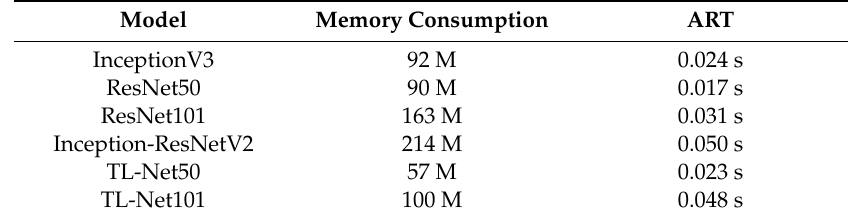
Table 4. The memory consumption and the running time of some typical CNNs and TL-Nets. “ART” denotes the average running time per